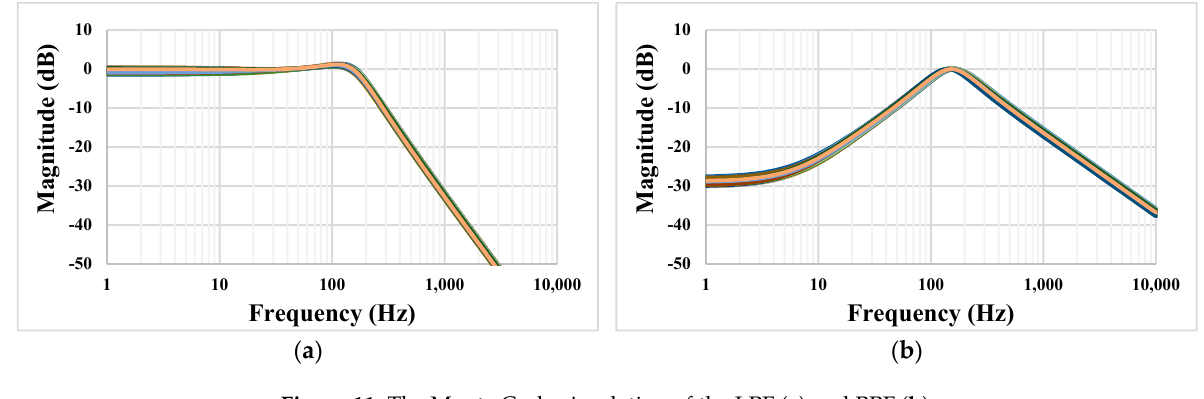
Figure 11. The Monte Carlo simulation of the LPF ( a ) and BPF ( b ). Figure 12 shows the simulation results of the LPF and BPF with the process, voltage, and temperature variations. The process corners were fast-fast, fast-slow, slow-fast, and slow-slow, the voltage supply corners were in the range of V DD ± 10%, and the temperature corners were 0 °C and 70 °C.